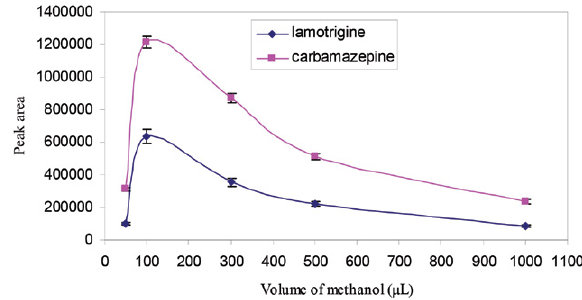
Figure 6. Effect of volume of methanol on the extraction efficiency, Extraction conditions: extraction solvent: [C8MIM][PF6], extrac-